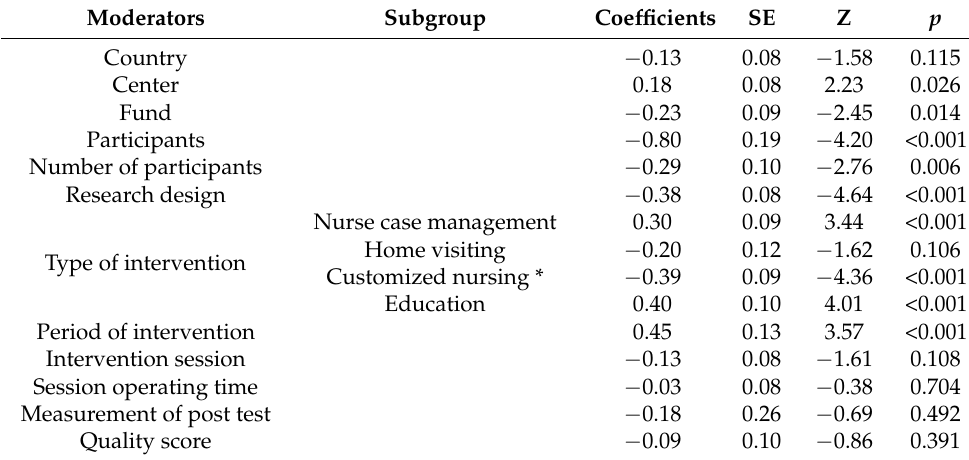
Table 5. Meta-regression analysis on HbA1C.